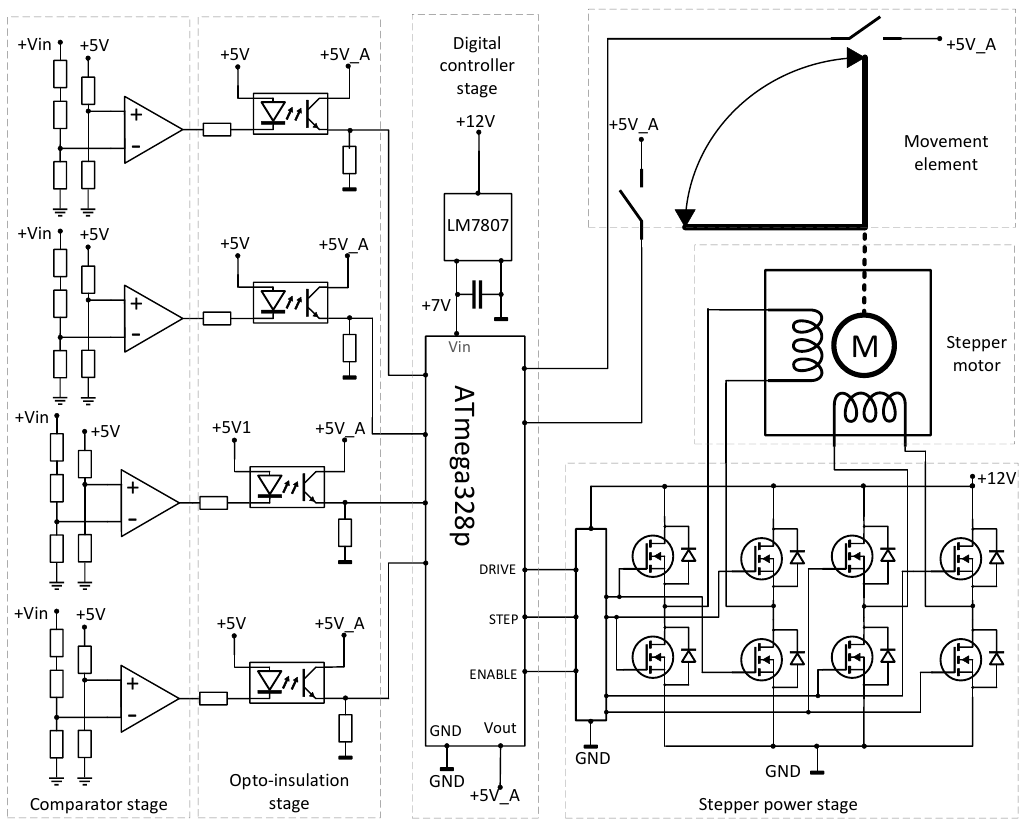
Figure 13. Current flow schematic for the proposed angular motor control.